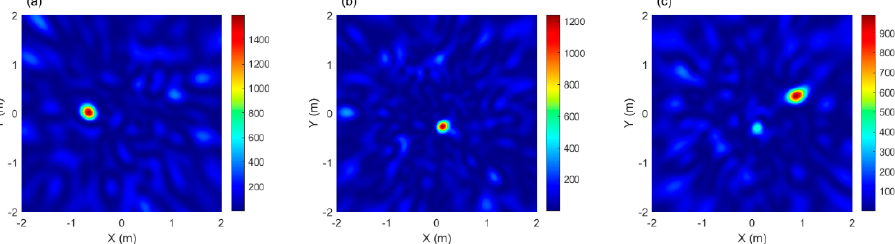
Figure 14. Localization results of the experimental study performed with BW − MUSIC and DNNs: ( a ) s 1 , ( b ) s 2 , and ( c ) s 3 . Table 2. Localization error of the experimental study performed with BW − MUSIC and DNNs. Sound Source Error ( m ) s 1 0.14 s 2 0.11 s 3 0.09